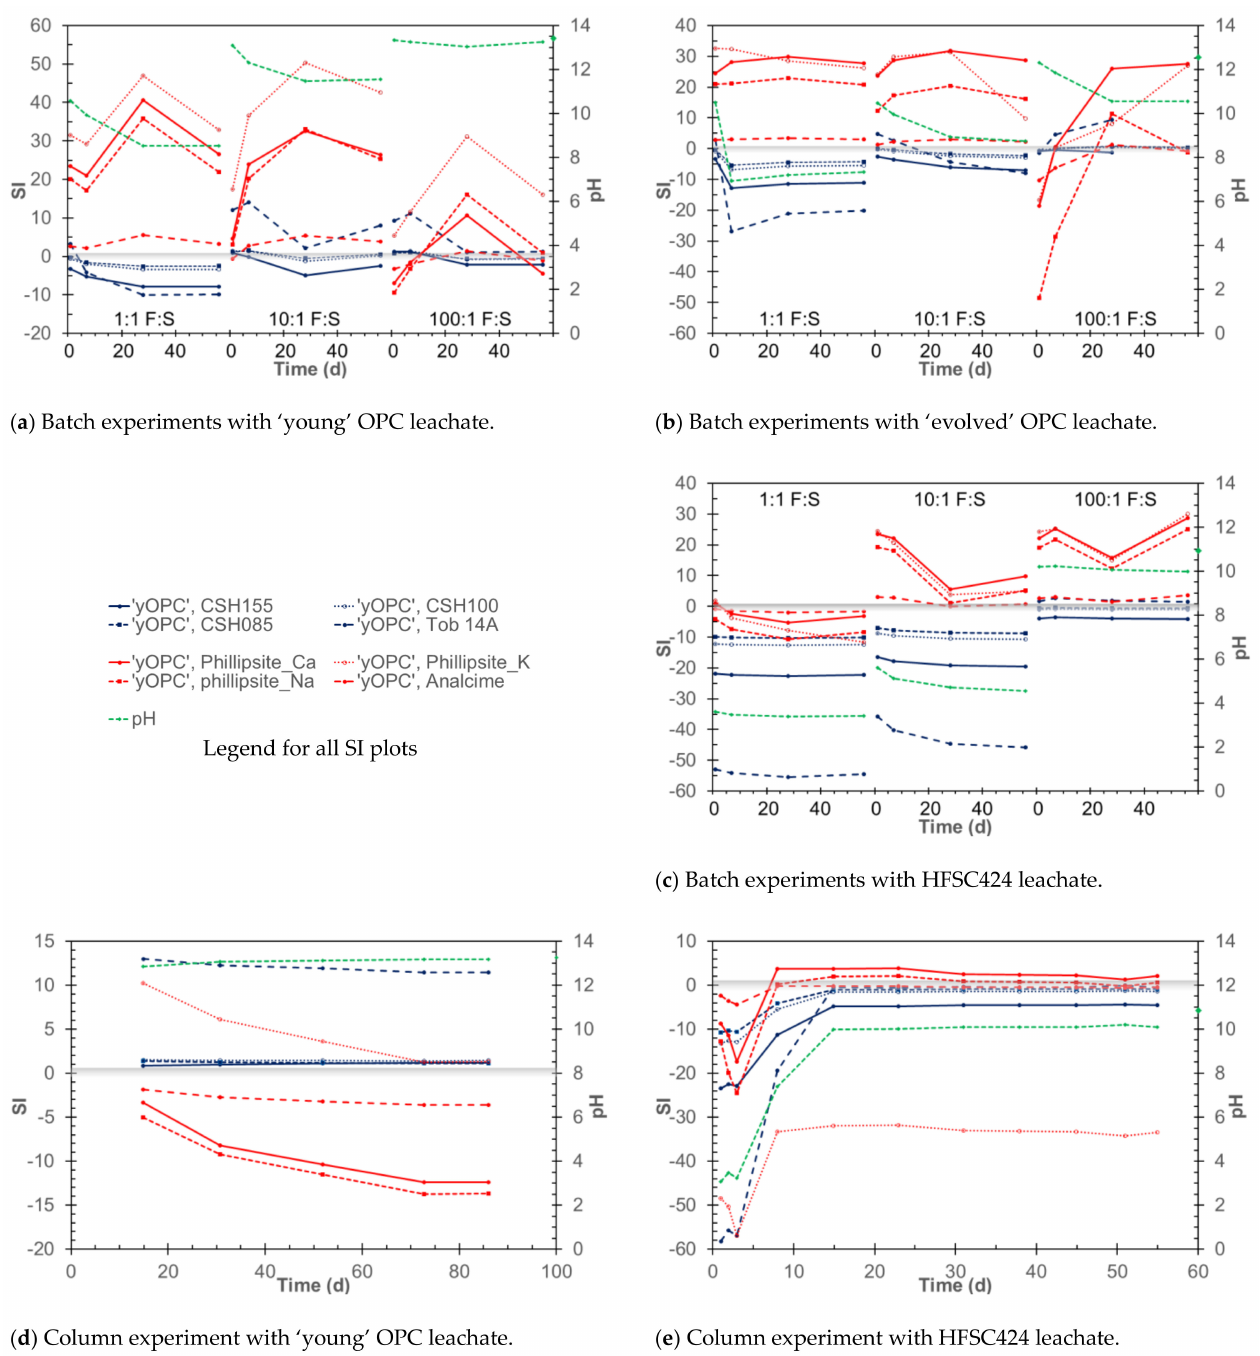
Figure 7. Indicative C-S-H and zeolite mineral saturation indices (SI) with time, together with pH. ( a ) Batch experiments with ‘young’ OPC leachate. ( b ) Batch experiments with ‘evolved’ OPC leachate. ( c ) Batch experiments with HFSC424 leachate. ( d ) Column experiment with ‘young’ OPC leachate. ( e ) Column experiment with HFSC424 leachate. Batch experiments are plotted from low to high F:S ratio for comparison with the flow experiments (C-S-H in blue, zeolites in red, pH in green). Shaded grey line indicates equilibrium state, i.e., SI = 0; below this line minerals will tend to dissolve, and above it they may